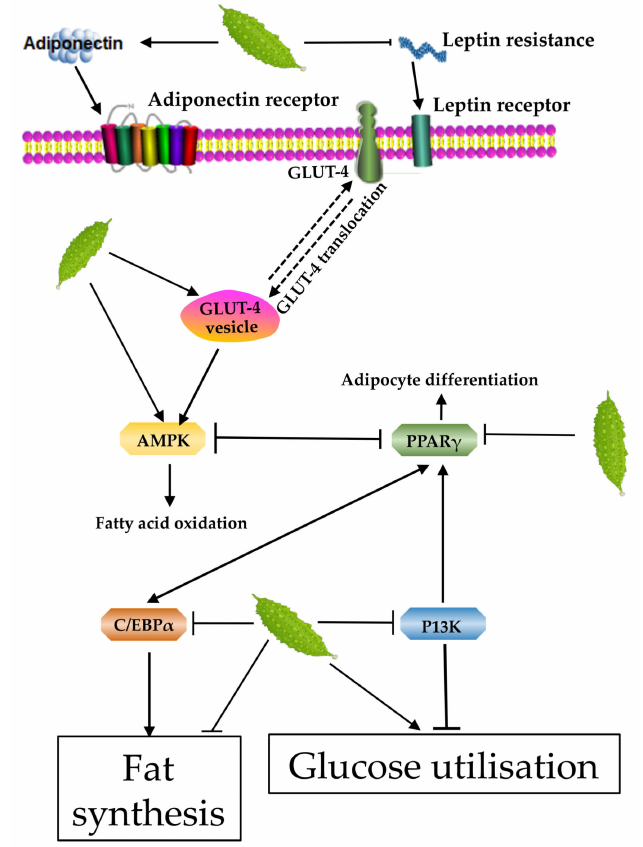
Figure 4. Possible mechanisms contributing to the inhibition of fat synthesis and glucose utilization of M. charantia . M. charantia stimulates glucose transporter 4 (GluT-4) to migrate to the cell membrane and mediate glucose uptake by increasing adiponectin, and the adenosine monophosphate-activated protein kinase (AMPK) activity. In addition, M. charantia blocks the expression of PPAR γ , and PPAR γ downstream pathway including C / EBP α and PI3K to reduce the accumulation of